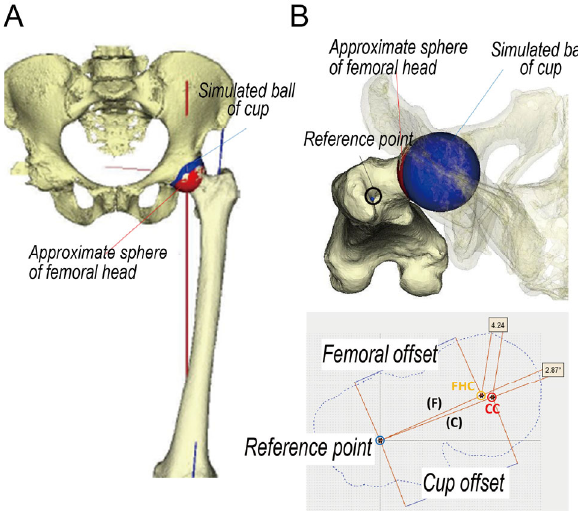
Figure 3. ( A ) Three-dimensional matching bone model. ( B ) Projection image of a three-dimensional matching bone model. F: femoral offset, C: cup offset.